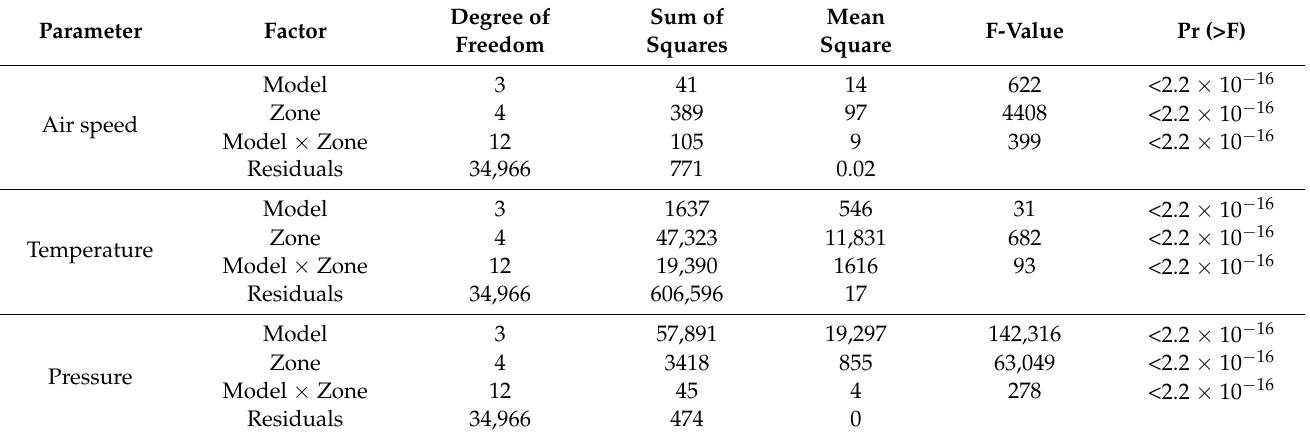
Table 3. ANOVA of environmental data from five animal-zones at Plane